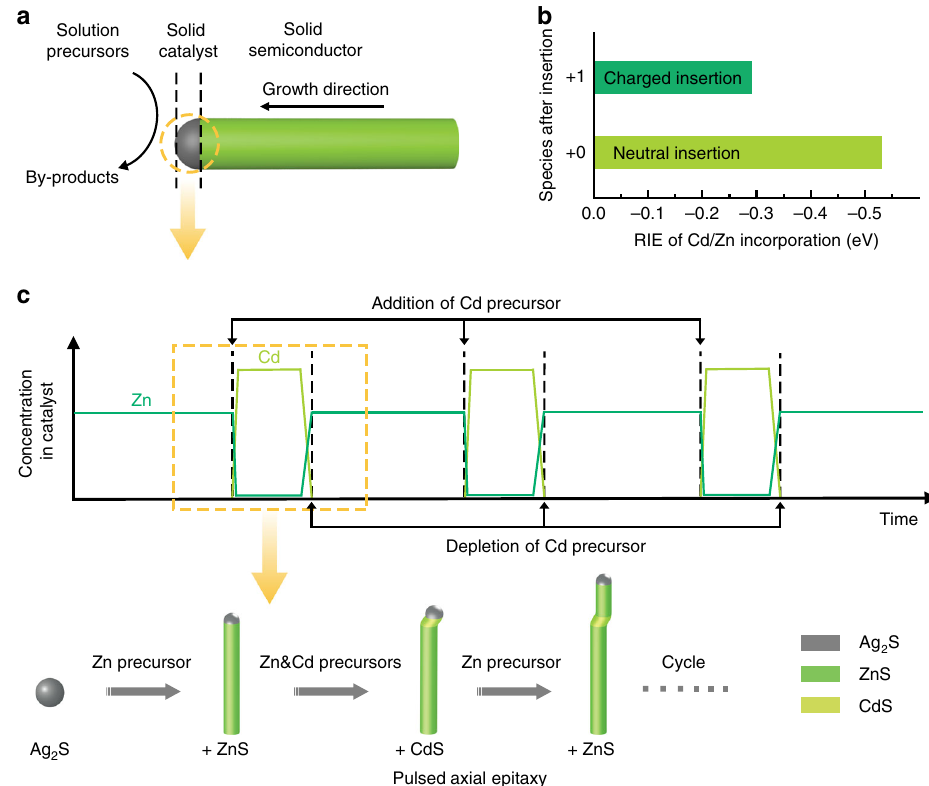
Fig. 1 One-pot growth of colloidal QDNWs via pulsed axial epitaxy. a Schematic of the SSS growth mechanism for one-dimensional (1D) semiconductor nanowires. b DFT-calculated relative intercalation energies (RIE) for neutral ( + 0) and charged ( + 1) insertion of Cd/Zn into Ag 2 S catalysts, respectively. In both cases, Cd insertion is energetically favorable over Zn. c (Upper panel) Schematic concentration evolutions of semiconductor atoms in catalysts with reaction time during the pulsed axial epitaxy. Addition of Cd precursor results in overwhelming incorporation of Cd into the Ag 2 S host catalysts compared with that of Zn. In each cycle, CdS QDs epitaxially stack in nanowires right after the introduction of Cd precursor, followed by re-growth of ZnS segments, enabling the in-situ axial epitaxy of QDs in nanowires (bottom